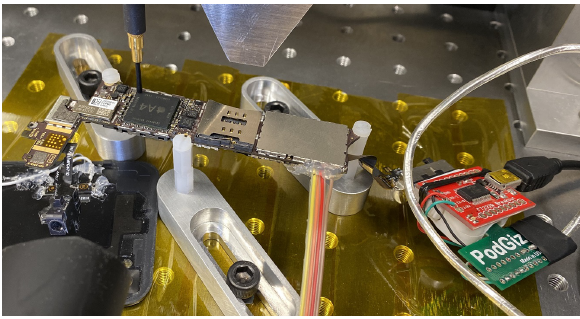
Figure 1: iPhone 4 mainboard mounted on a